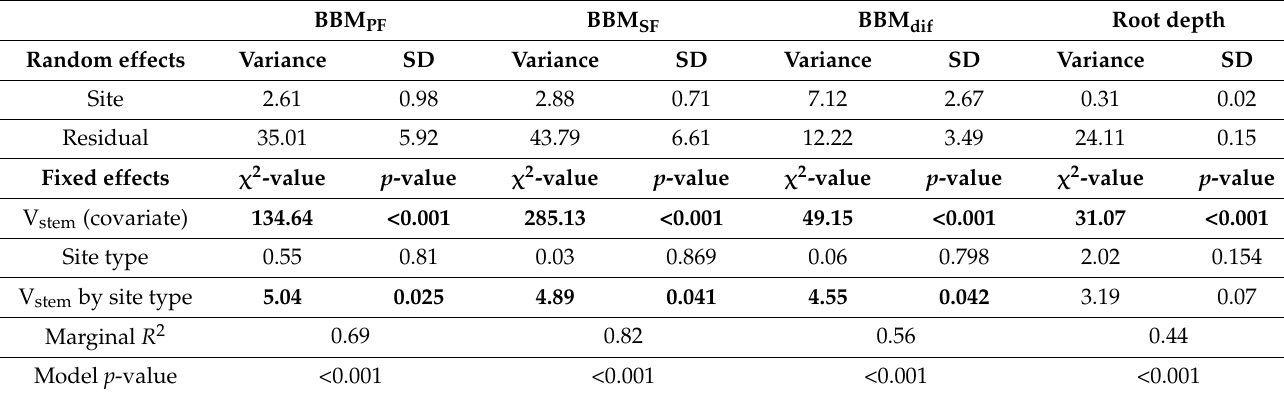
Table 3. Statistics of the refined mixed models relating basal bending moment at the primary (BBM PF ) and secondary (BBM SF ) failures of birch stem under destructive static loading as well as the difference (BBM dif ) between both BBM PF and BBM SF and root depth. Variances of the random effects of site and strength ( χ 2 -value) and significance ( p -values) of the fixed effects (significant effects are highlighted in bold) are shown. V stem– stem volume; SD–Standard